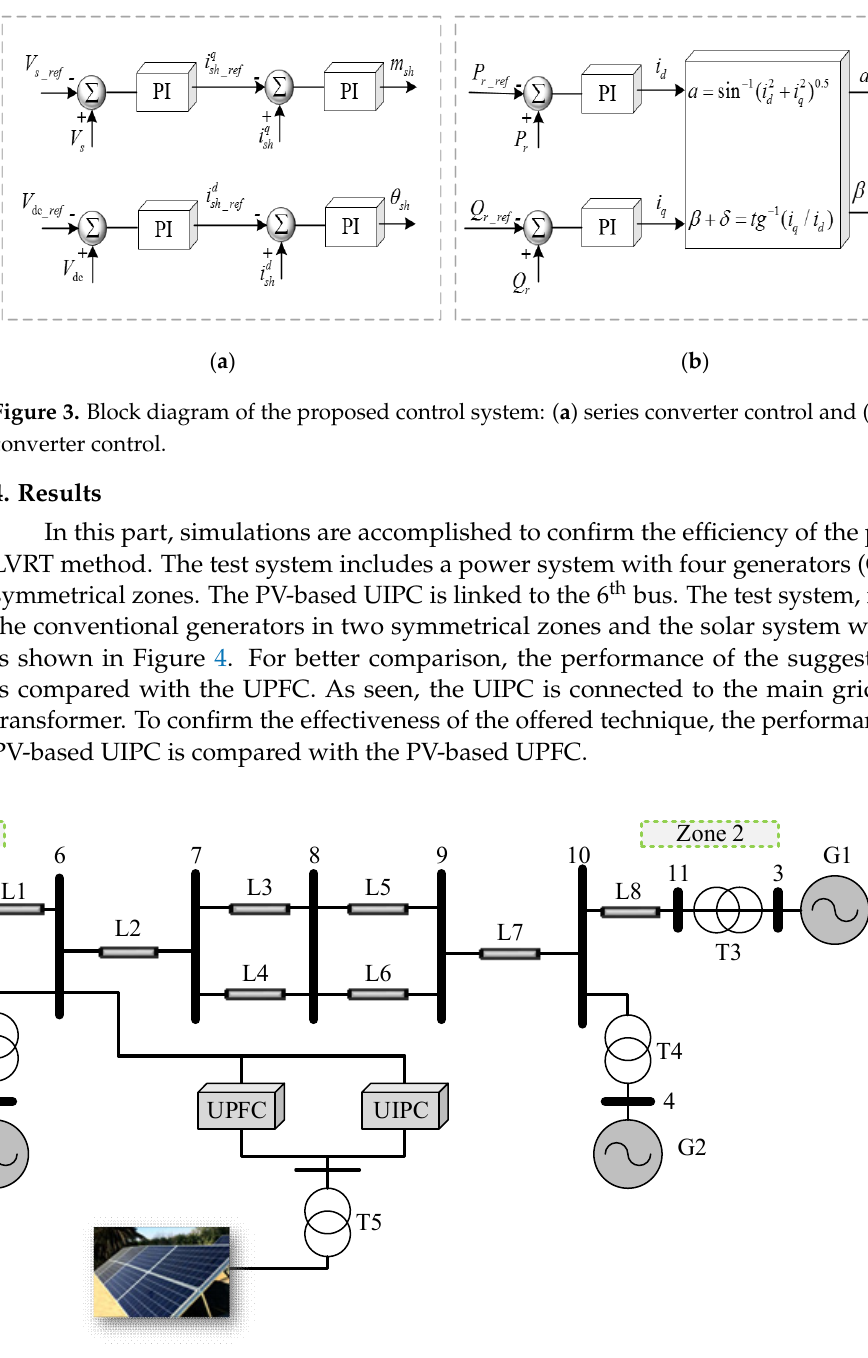
Figure 4. Photovoltaic ( PV)-based UIPC connected to the main grid.